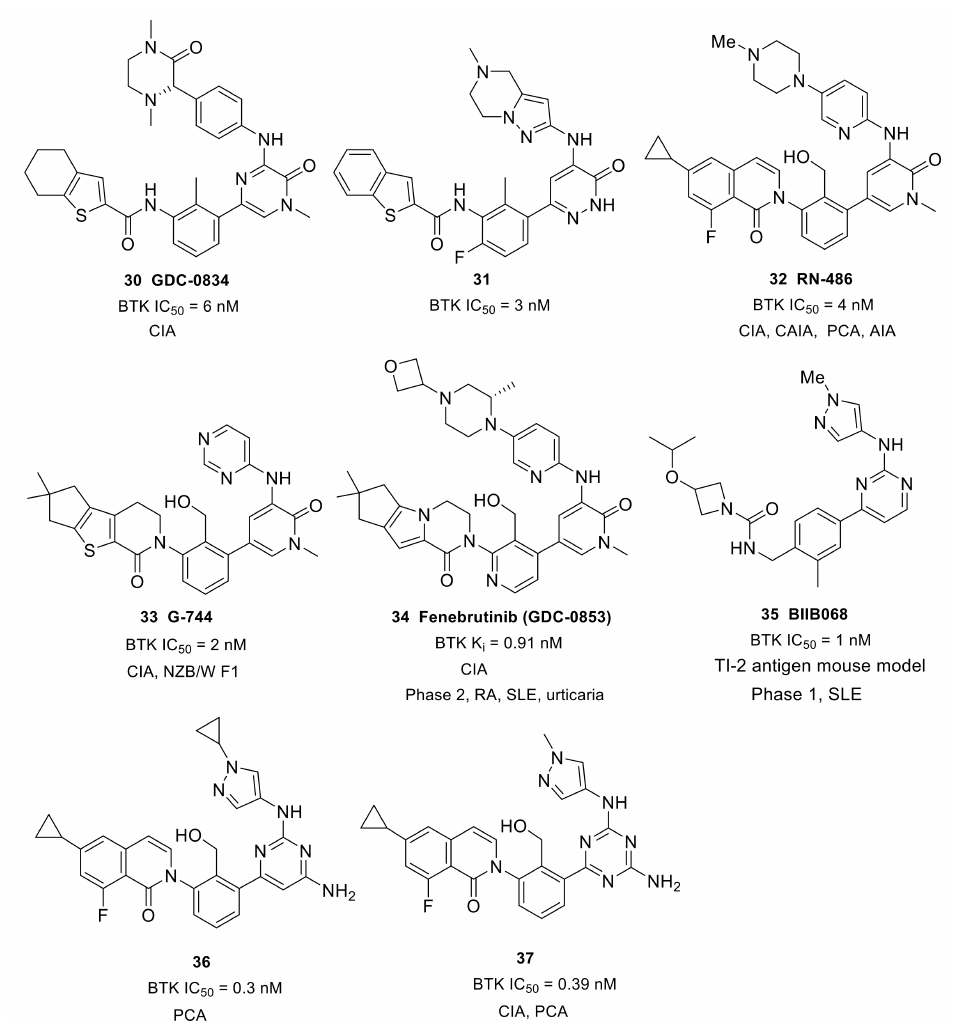
Figure 10. The representative structures of non-covalent reversible BTK inhibitors with monocyclic heterocycle scaffolds and their progress in the treatment of autoimmune and inflammatory diseases. PCA, passive cutaneous anaphylaxis; AIA, Adjuvant-Induced